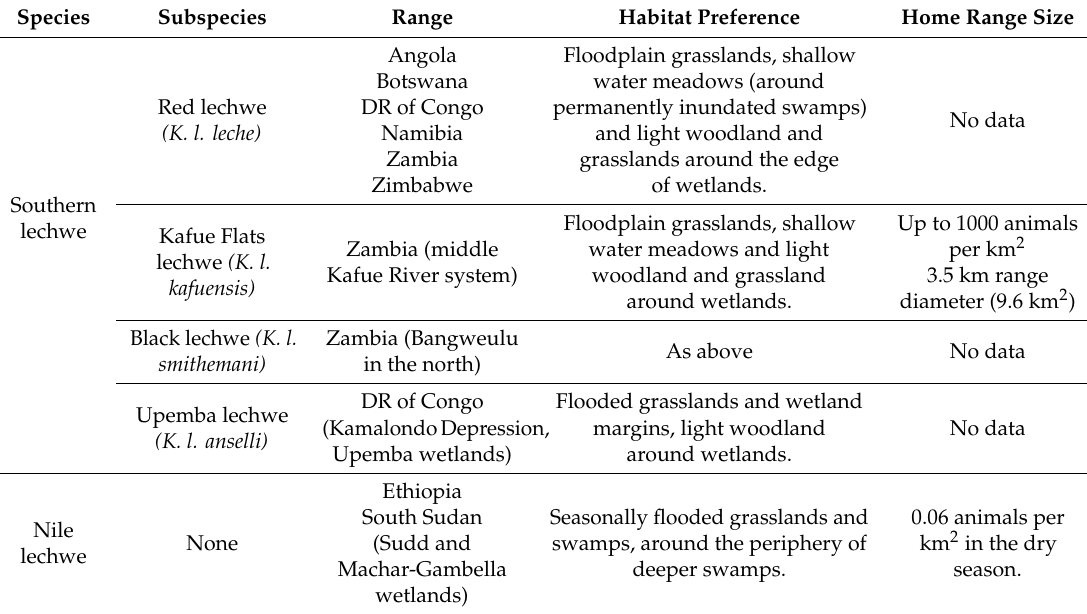
Table 1. Summary of the population ecology of red and Nile lechwe